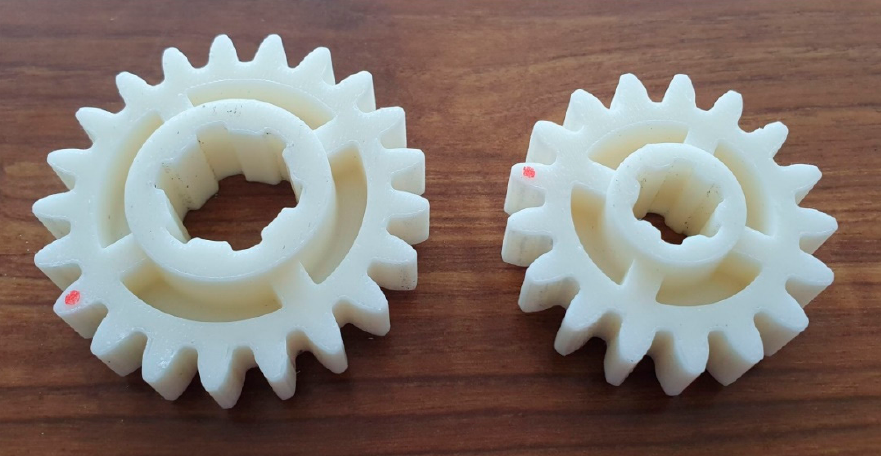
Figure 1. Gears manufactured using the FDM technique from ABS M-30.